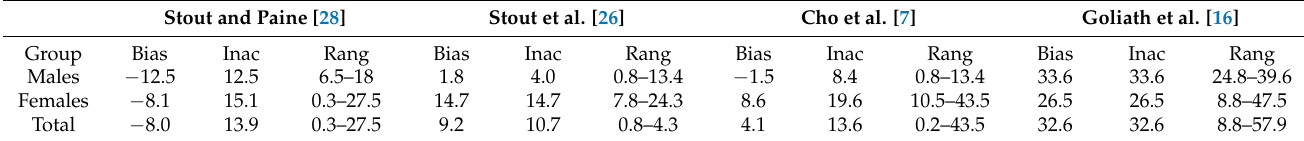
Table 7. Bias, inaccuracy and absolute error range for the age estimates of the rib sample divided by sex.